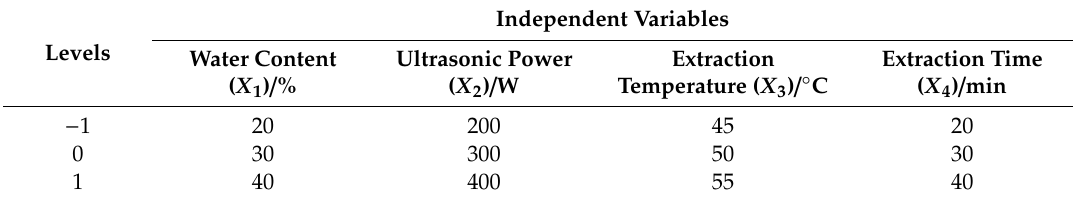
Table 2. Experimental design independent variables and their